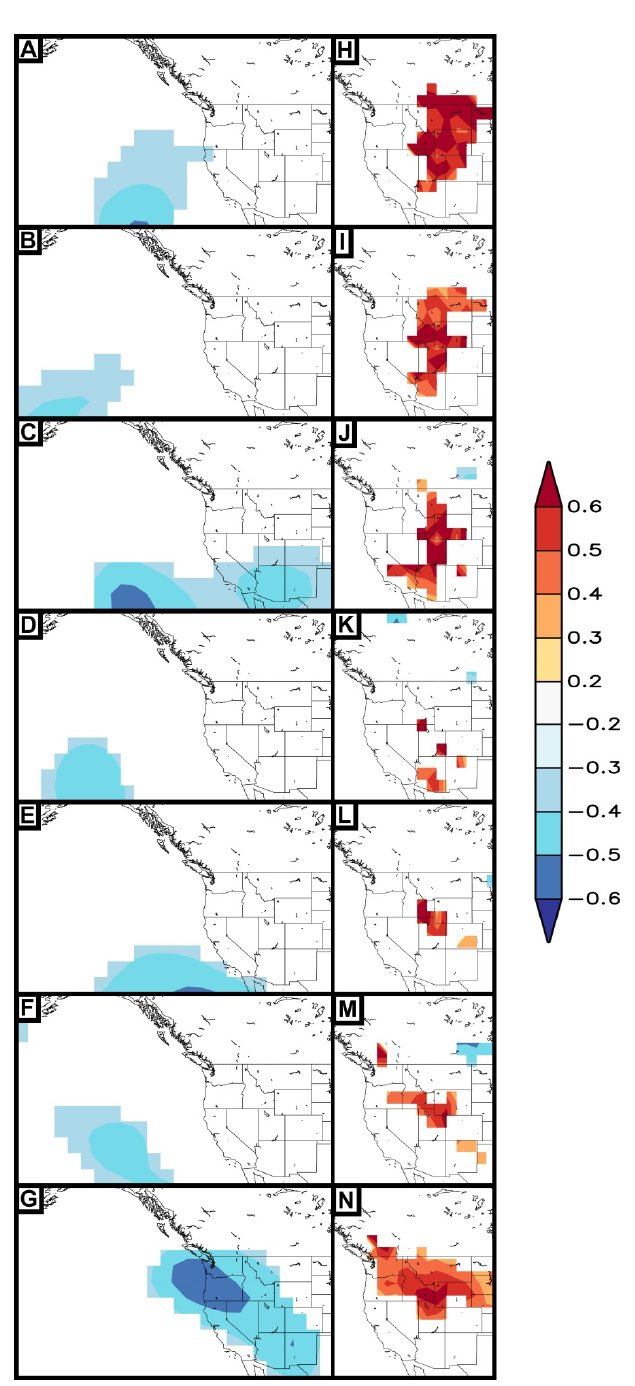
Figure 4. Significant ( p < 0.05) correlations between January ASIE and monthly 300 hPa ( A – G ) and monthly soil moisture ( H – N ) from January (top) through July (bottom).